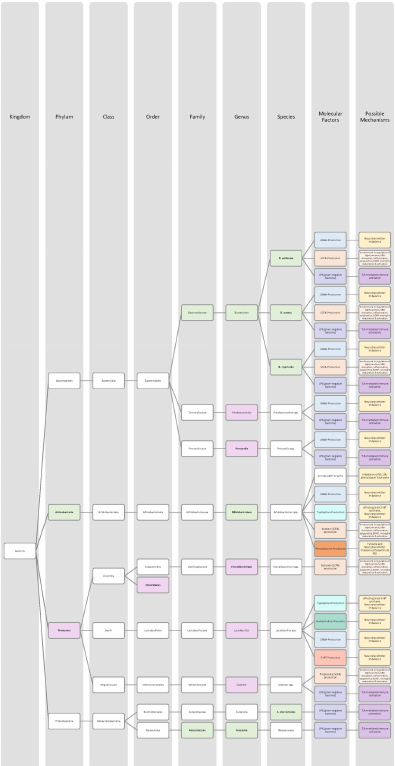
Figure 2. Visual representation of the changes in microbiota composition in ADHD patients from Table 2. The pedigree design highlights the taxonomic classification of the dysbiotic bacteria. Light green cells stand for an increase and the light red cells for a decrease, respectively. Significant changes are shown in bold letters ( p < 0.05 or LDA values > 2). White cells indicate that no changes were reported. The last two columns contain additional, non-exhaustive information on how the bacteria are thought to impact the pathogenesis. The second last column to the right depicts bacterial molecular factors, which may be components of the bacteria or bacterial metabolites. Finally, the last column lists possible mechanisms by which these molecular factors may interfere with disease development. The colours summarise factors or mechanisms that are repetitive. Bacterial production of GABA (light blue, [36]), tryptophan (turquoise, [28]), acetylcholine (emerald colour, [18,20]), phenylalanine (dark orange, [27]), or 5-HT (salmon colour, [28]) may lead to an imbalance in central nervous system neurotransmitters (yellow). Gram-negative bacteria’s cell wall containing LPS (light purple) can stimulate TLRs located on immune cells (lilac, [21,31]). TLR-mediated immune activation is eventually leading to systemic inflammation, BBB disturbance, and neuroinflammation [14]. SCFAs deriving from bacteria are involved in microglia maturation and activation, BDNF-production, tight junction regulation in the gut barrier as well as in the BBB, epigenetic and inflammatory processes (light orange, [18,20,26,29]). 5-HT = serotonin; ADHD = attention deficit hyperactivity disorder; BBB = blood–brain barrier; BDNF = brain-derived neurotrophic factor; GABA = gamma- Aminobutyric acid; LPS = lipopolysaccharide; SCFA = short-chain fatty acid; TLR = Toll-like